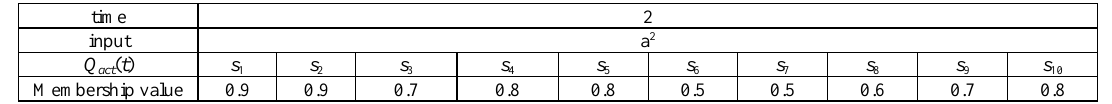
Table 3. Initial state designator  for string